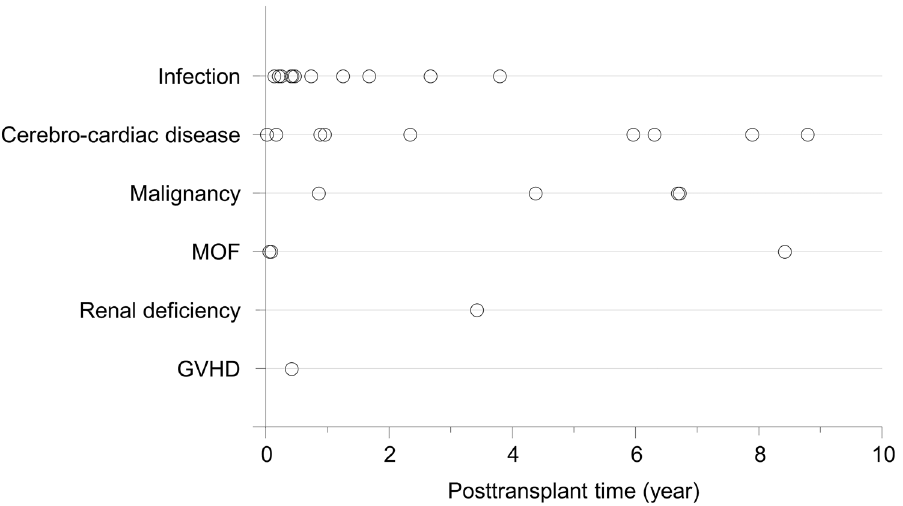
Figure 3. Timing of pancreas graft loss due to DWFG based on the cause of DWFG in SPK cases. ACH plot indicates the timing and cause of DWFG. DWFG death with a functioning graft, GVHD graft versus host disease, MOF multiple organ failure, SPK simultaneous pancreas-kidney